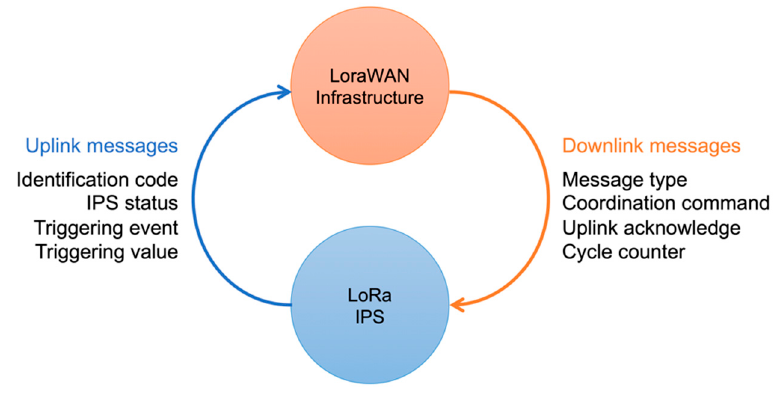
Figure 4. Schematic block diagram of the proposed LoRaWAN architecture for the coordination of smart IPSs.